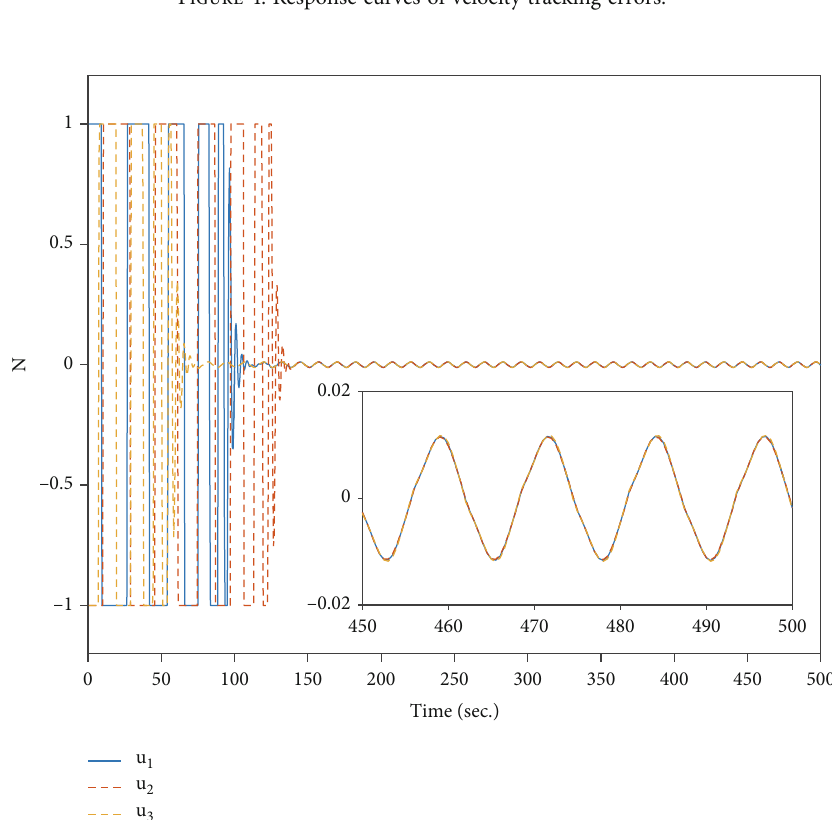
Figure 5: Response curves of control force.